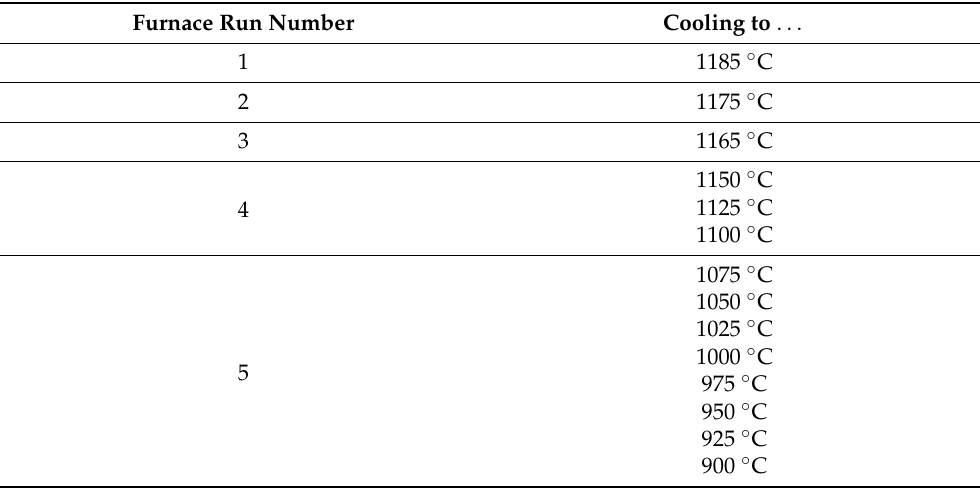
Table 1. Overview of the heat treatments performed. Each sample is first solution heat treated at 1200 ◦ C for 10 min and then cooled to the specified temperature at 1 K/min. The furnace run number shows which samples were pooled together in one furnace